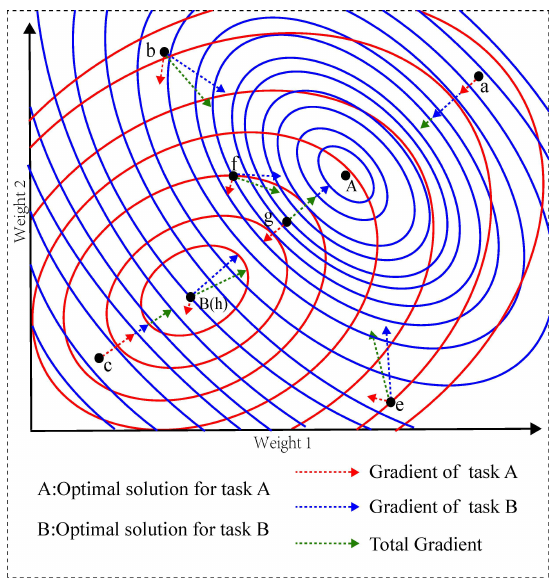
Figure 1. Illustration of the difficulty of multi-task learning. The axis of x and y denotes the different parameters. The red lines and blue lines denote the contour line of the loss of task B and A, respectively. The sparsity of the contour lines indicates the value of the gradient of tasks A and B, respectively.